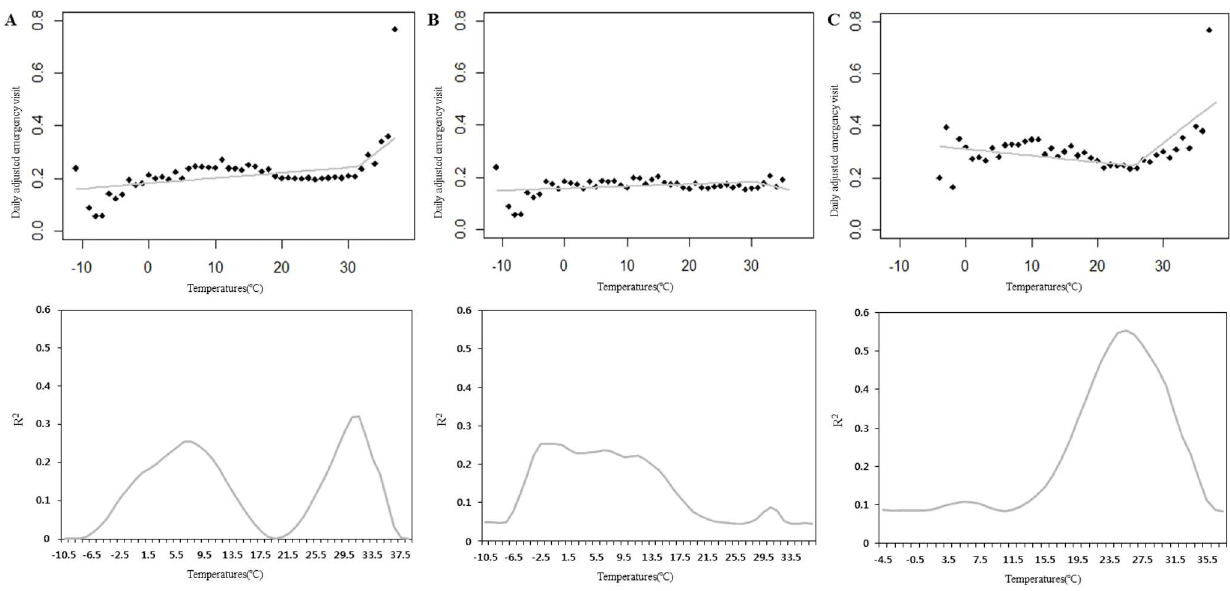
Figure 1. Daily adjusted emergency visit (DAEV) rate for MI according to maximum temperature by regions: A. Combined regions, B. Central region, C. Southern region. Lower figures showed change of R 2 values in each temperature by piecewise analysis and maximum R 2 value was chosen as the inflection point. The maximum R 2 value of the central region was 30.5 u C; however, it did not show a threshold effect.